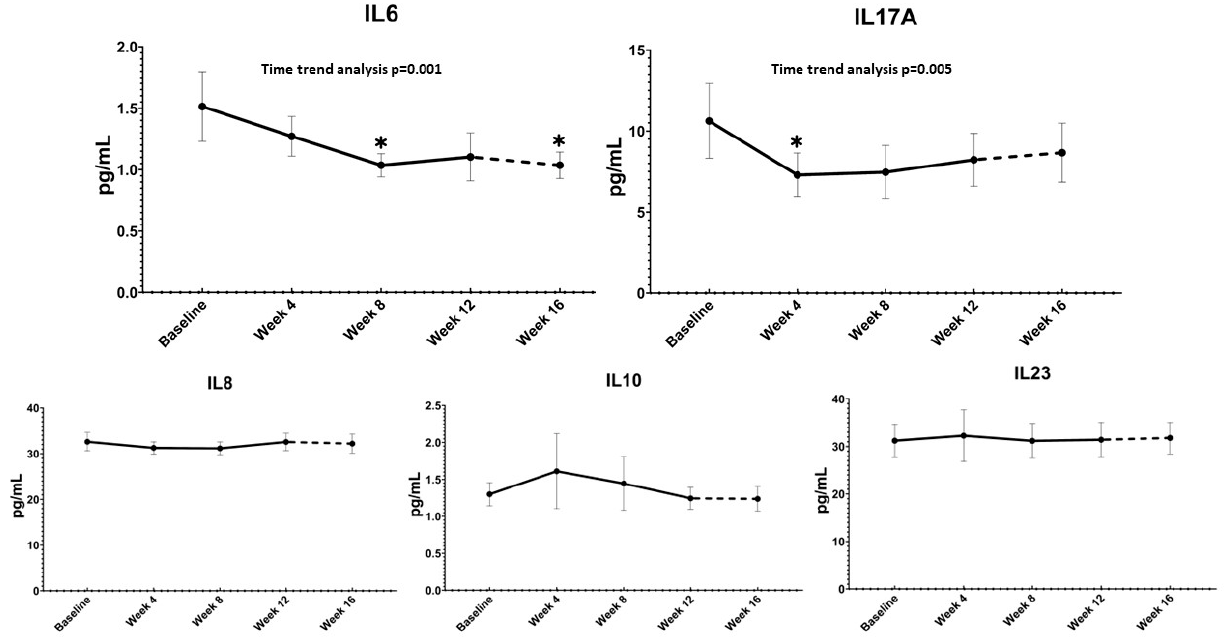
Figure 1. Absolute changes with time trend analysis of the overall cohort over time of IL-6, IL-17A, IL-10, IL-8 and IL-23. Treatment was administered from baseline to week 12 (solid line), the follow-up period without supplementation (from week 12 to week 16) is depicted by the dashed line. * p < 0.05 with respect to baseline (one-way ANOVA for repeated measures). Error bars show 95% Confidence Interval.